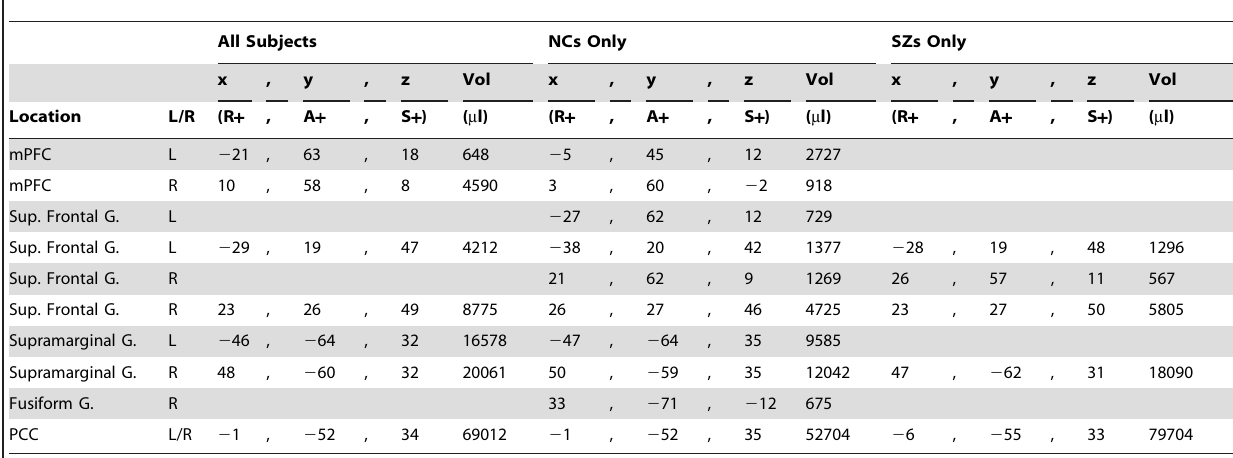
Table 2. Results of Resting State Functional Connectivity (rsFC) analyses.